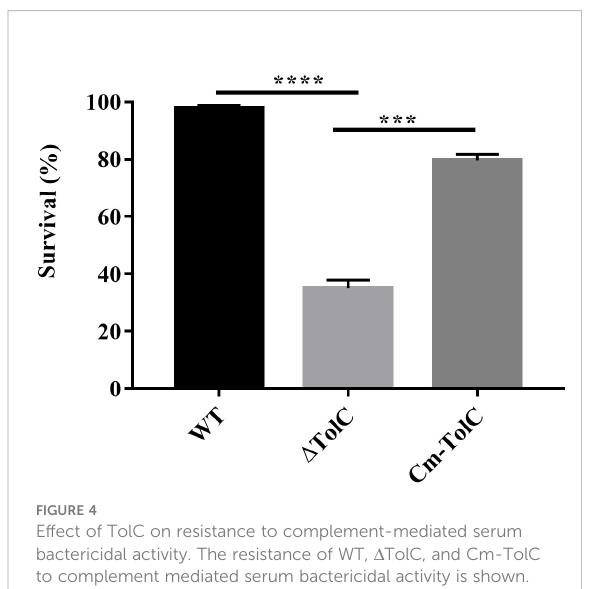
FIGURE 4 Effect of TolC on resistance to complement-mediated serum bactericidal activity. The resistance of WT, D TolC, and Cm-TolC to complement mediated serum bactericidal activity is shown. The results are expressed as the means of recovered bacteria per milliliter. Statistical analyses were performed using a two unpaired t-test. Statistically signi fi cant difference is indicated as *** p ≤ 0.001 and **** p <